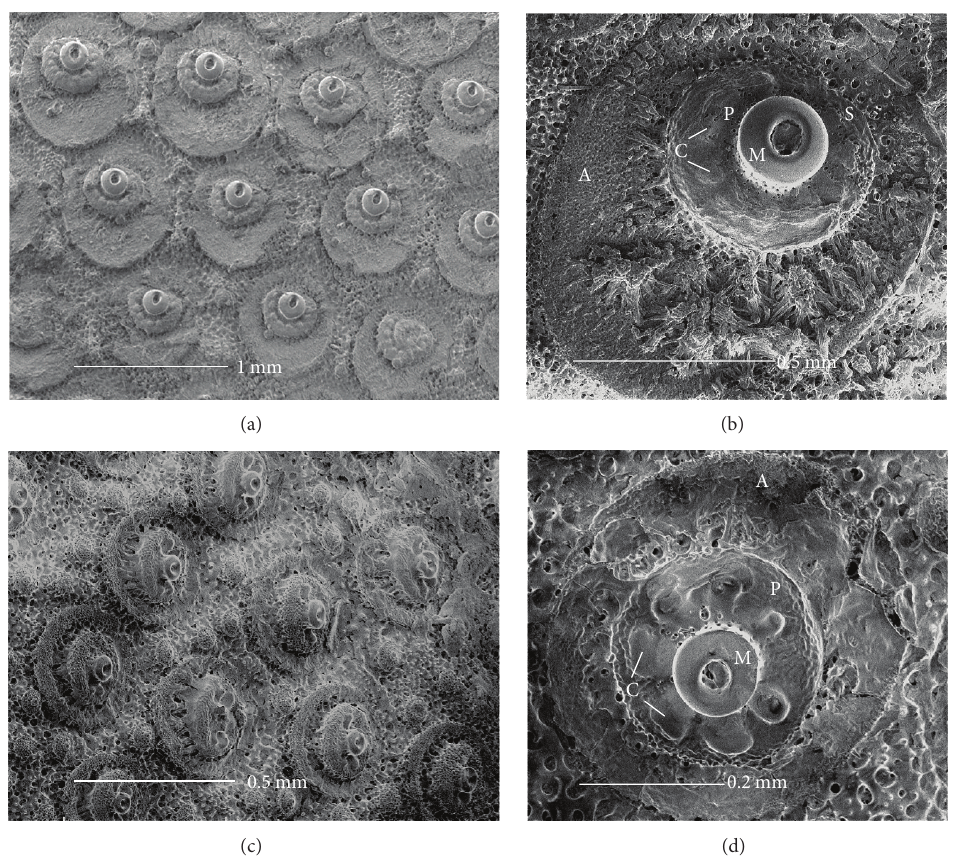
Figure4:Scanningelectronmicrographsofspinetuberclesof Brisasterfragilis